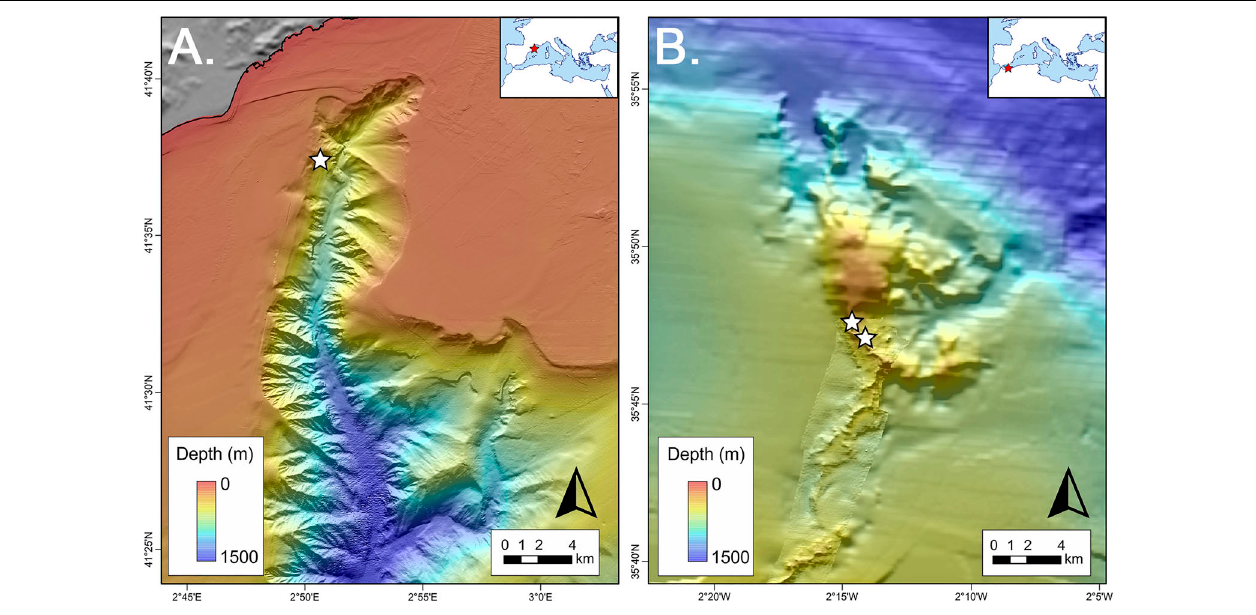
FIGURE 1 | (A) Location of the collection site (white star) in the Blanes Canyon, north-western Mediterranean Sea). (B) Location of the collection site (white stars) in the Cabliers Coral Mound, in the Alboran Sea. Projected view [UTM Zone 31N (WGS84)] with geographic (WGS84) coordinates indicated for reference.